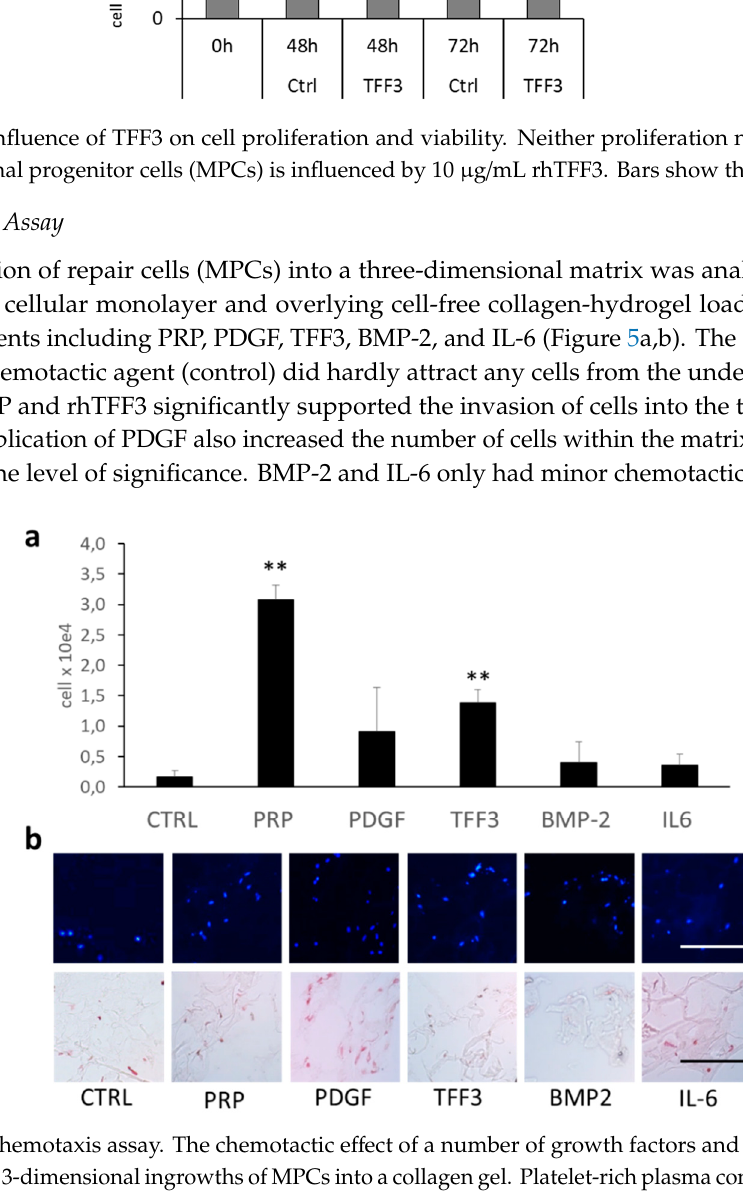
Figure 5. Chemotaxis assay. The chemotactic effect of a number of growth factors and cytokines was detected by 3-dimensional ingrowths of MPCs into a collagen gel. Platelet-rich plasma concentrate (PRP) and TFF3 significantly stimulated the ingrowth of MPCs, while other growth factors and cytokines had minor effects ( a ). DAPI and Fast Red staining visualize the ingrown cells within the three-dimensional collagen matrix ( b ). Bars = 100 µm. ** p < 0.01.